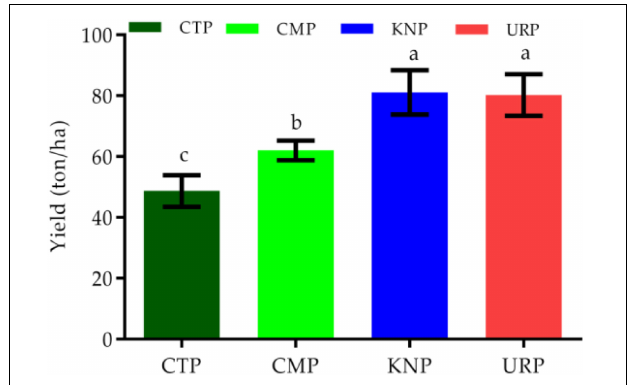
FIGURE 7 | Chinese cabbage yield in different treatments with standard error bar and letters (a, b, and c) presenting the statistical significant variation ( p < 0.05).